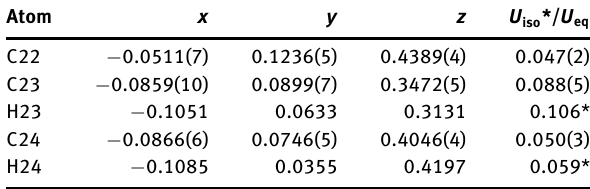
Table 2: Fractional atomic coordinates and isotropic or equivalent isotropic displacement parameters (Å 2